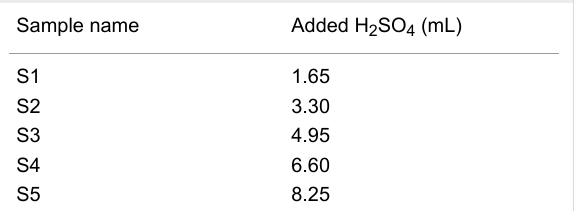
Table 3: Sample names and corresponding volume of 12 M H 2 SO 4